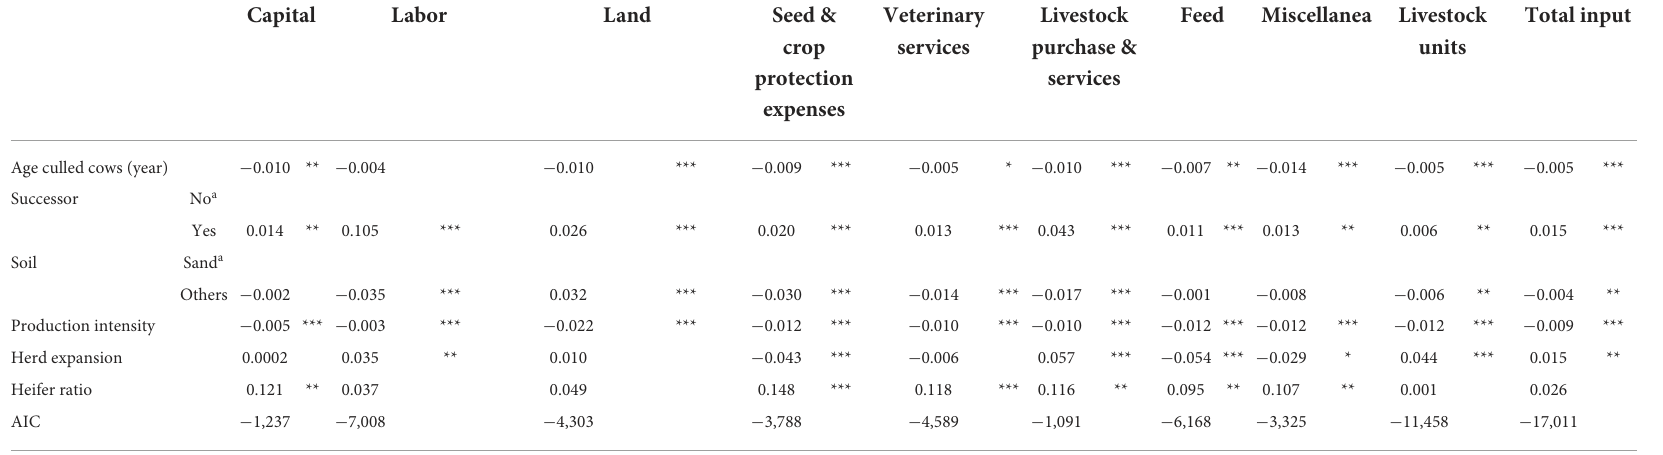
TABLE 4 Results of bootstrap truncated regression models on technical inefficiency for, respectively, capital, labor, land, seed & crop protection expenses, veterinary services, livestock purchase & services, feed, miscellanea, livestock units, and total input with age of culled cows as longevity feature.